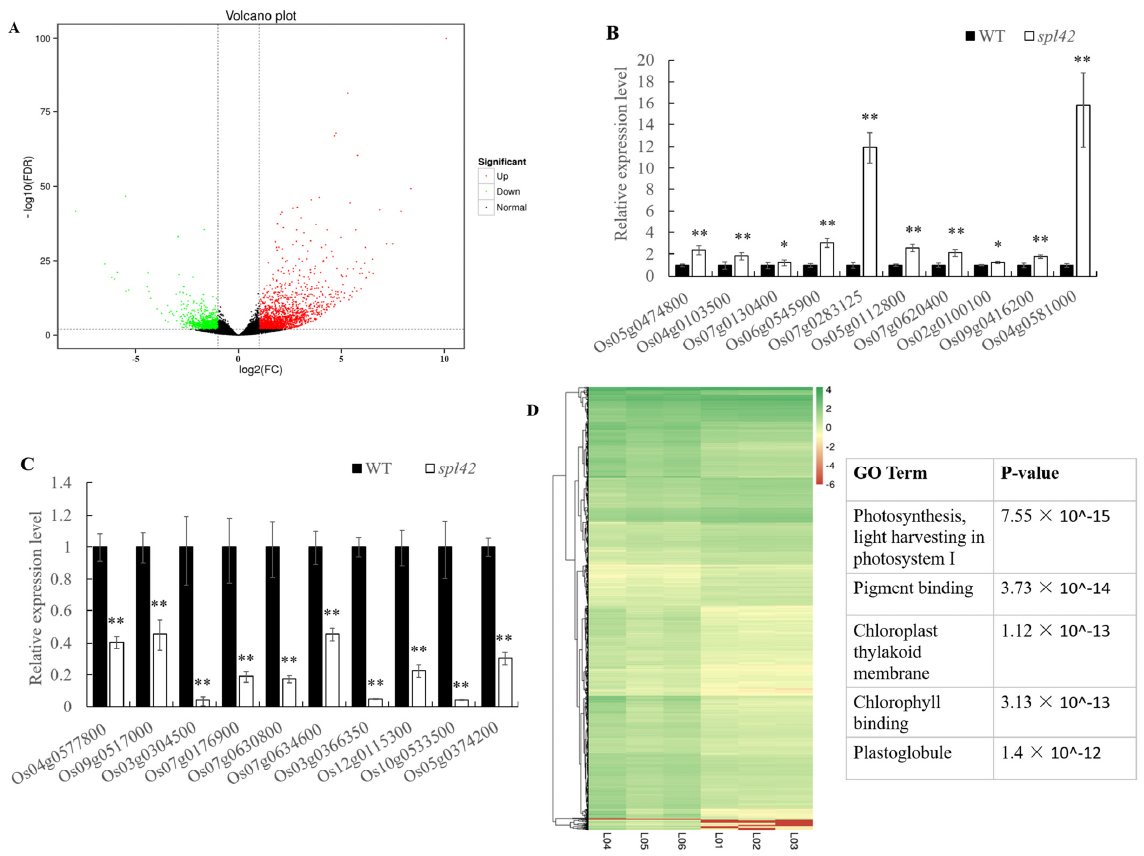
Figure 10. RNA-sequencing related data analysis of the wild type (WT) and the spl42 mutant. ( A ) Distribution of volcano plot of wild type and spl42 mutant. Volcano plot shows the differential expression of genes in accordance with fold difference and significant levels, and the criteria for significant differentially expressed gene screening were: |log 2 Ratio| ≥ 1 and q-value ≤ 0.05. ( B , C ) qRT- PCR analysis of 10 up-regulated and 10 down-regulated genes which are selected randomly from RNA-sequencing results. Asterisks indicate a significant difference between WT and the spl42 plants by Student’s t -test, ** p < 0.01; * p < 0.05. ( D ) Cluster analysis of differentially expressed genes in wild type and spl42 mutants.